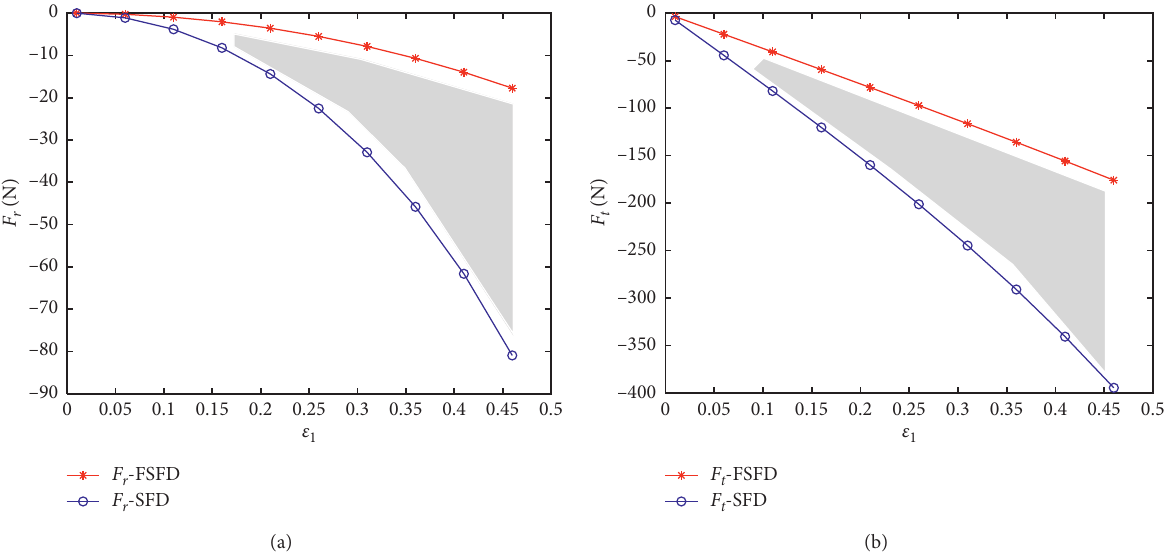
Figure 4: Film force vs. ε : (a) radial film force; (b) circumferential film 1